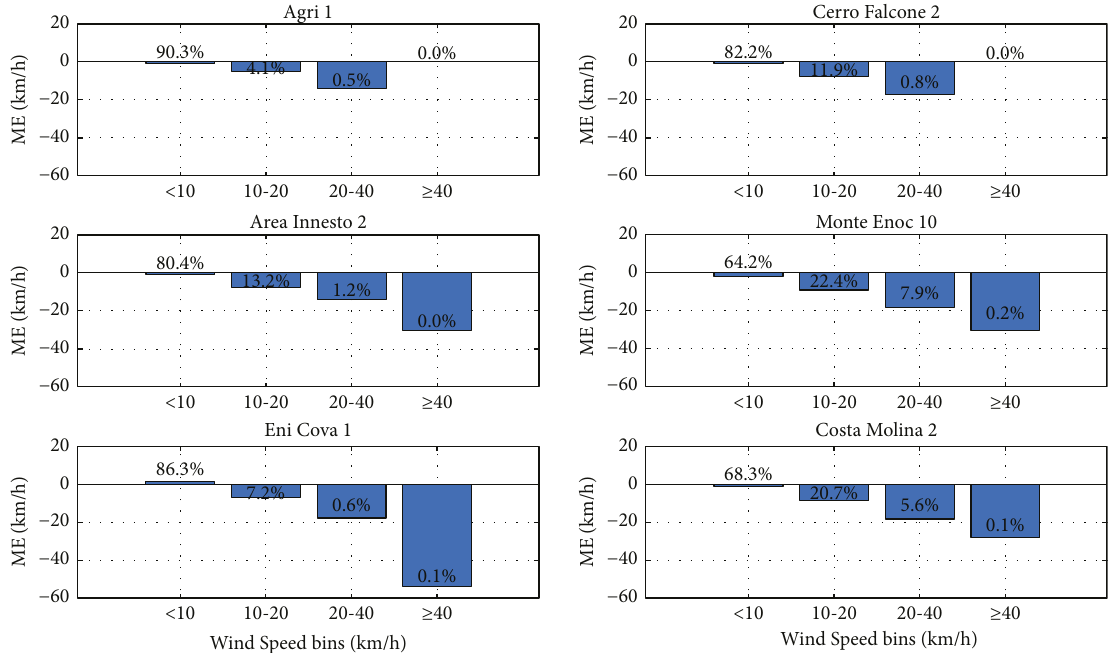
Figure 15: Mean errors for wind speed thresholds in the two years of the observation period over the six weather stations at day +1 as lead time for the KALM-HD model with 5 km. Values in red are referred to as the percentage of analyzed events in each